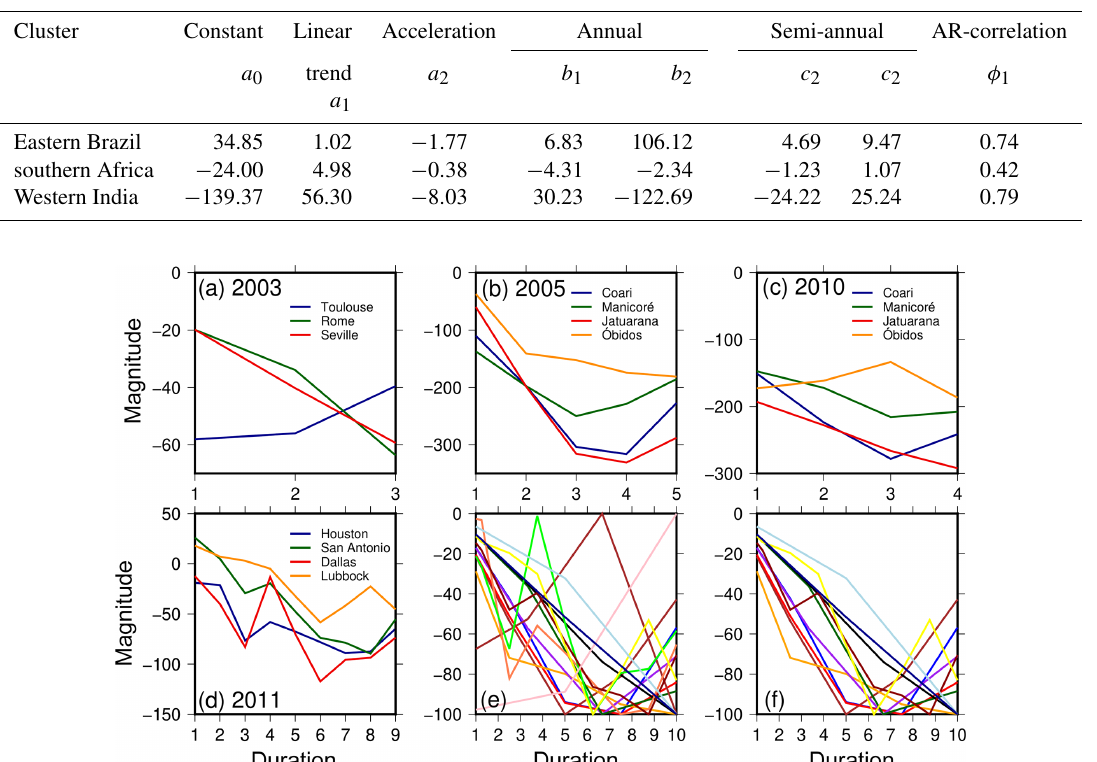
Figure 4. Extracted drought periods from GRACE-TWSC for the droughts in (a) Europe in 2003, (b) the Amazon river basin in 2005, (c) the Amazon river basin in 2010, and (d) Texas in 2011. (e) All droughts from (a) – (d) were transformed to standard severity and duration. Panel (f) is the same as (e) but after removing four time series with significant temporally different